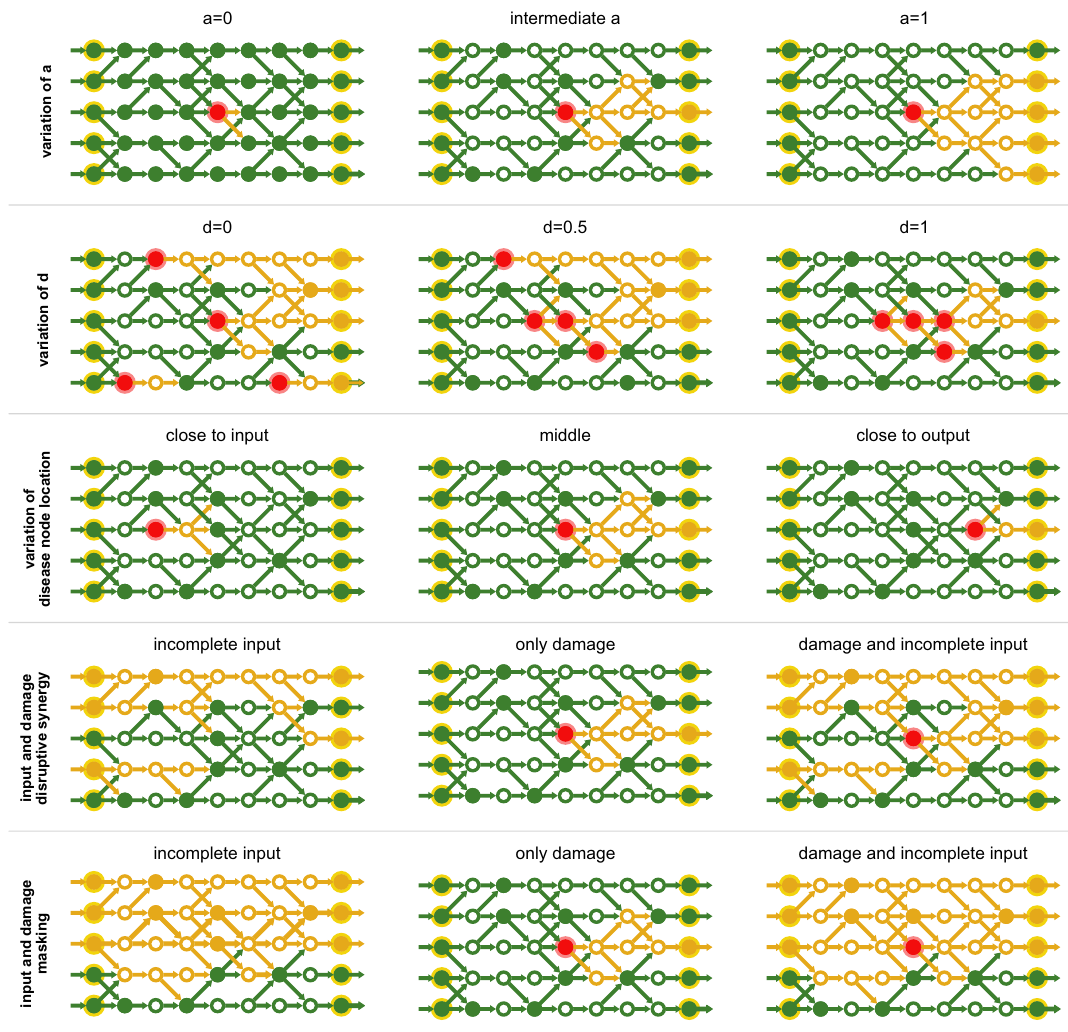
Figure 2. Schematic summaries of various aspects of the model. Red indicates non-functional nodes (i.e. the genetic predisposition for a disease, ‘disease nodes’). Green nodes and links indicate activity (‘flux’). Inactive components are indicated in yellow. All rows (except for the first one) use the same (intermediate) value of a . The first row shows how a affects the impact of non-functional nodes. The second row illustrates the effect of different clustering d for the same number of non-functional nodes D . The third row shows how the position of the non-functional nodes can affect the phenotype. The fourth row is an example of synergistic effects between network and environment. The fifth row shows an example of a genetic disease being masked by environmental